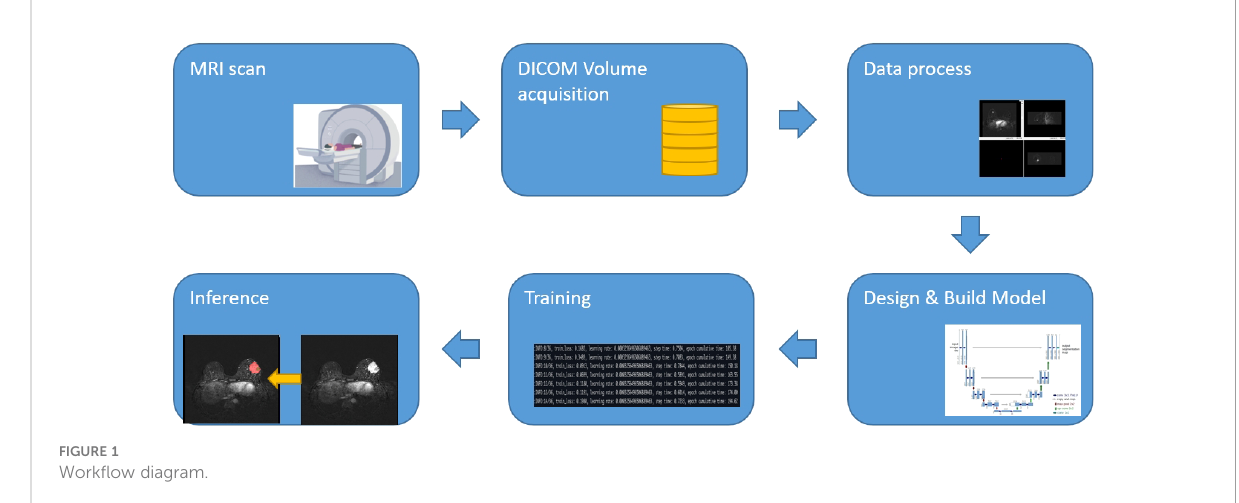
FIGURE 1 Work fl ow